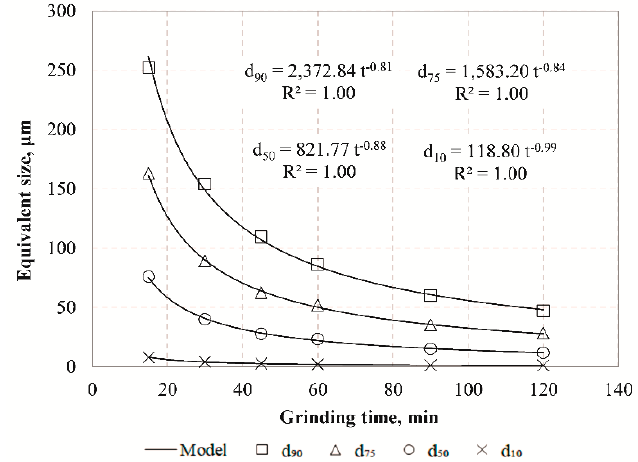
Figure 4. Equivalent particle size of slag products versus grinding time.